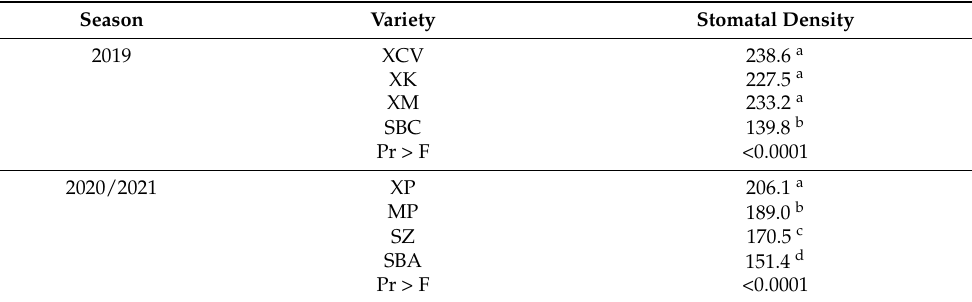
Table 7. Stomatal density measures for potted trials for seasons 2019 and